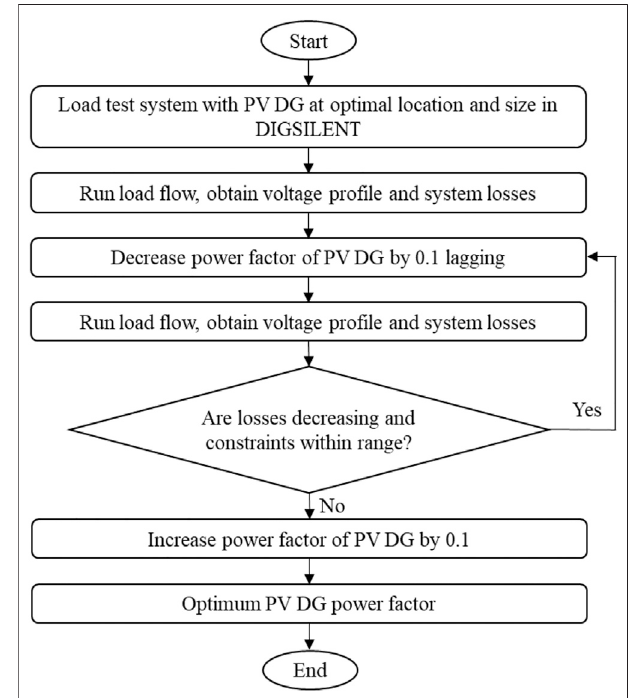
FIGURE 4 | Flowchart of optimal PV-DG power